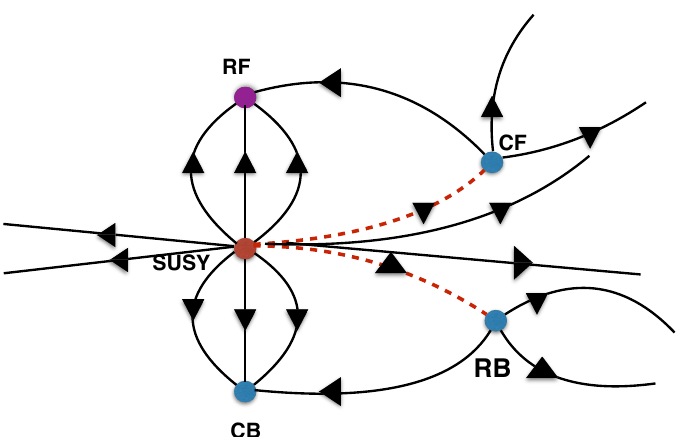
Figure 2. In this (cid:12)gure we present a qualitative sketch of the structure of large N critical (cid:13)ows from theory S, constructed in [15], when the most relevant deformation is tuned to zero. We have added to their discussion the extra (cid:13)ows denoted by dashed red lines, which are further (cid:12)ne-tuned, from the supersymmetric theory to the quasi-bosonic